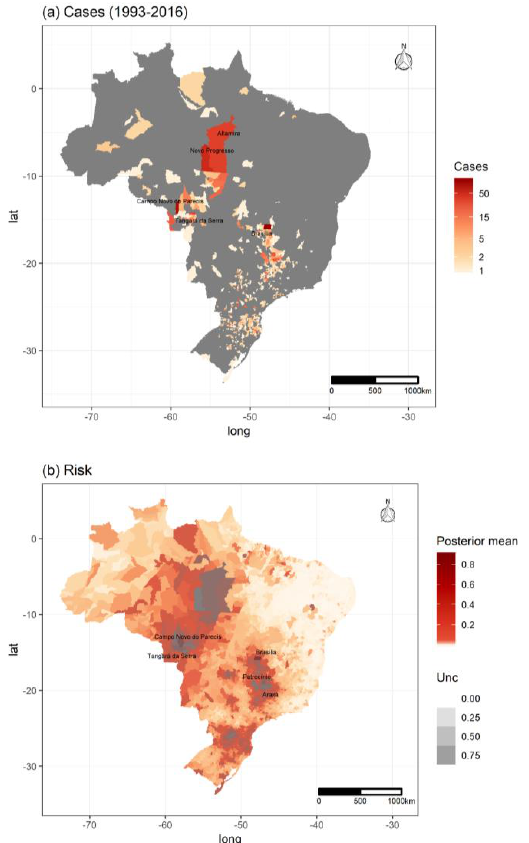
Figure 2. Hantavirus disease distribution in Brazil. ( a ) Observed values from 1993–2016, highlighting the municipalities with largest number of cases. Grey areas are municipalities with no notified cases; ( b ) Expected values for the probability of hantavirus disease in humans, predicted by a spatiotemporal model containing forest, climate, and social vulnerability, with uncertainty as transparency levels (Unc) based on the variation of credible intervals. The top five municipalities in terms of risk per year are highlighted. See the risk map without the uncertainty layer in Figure